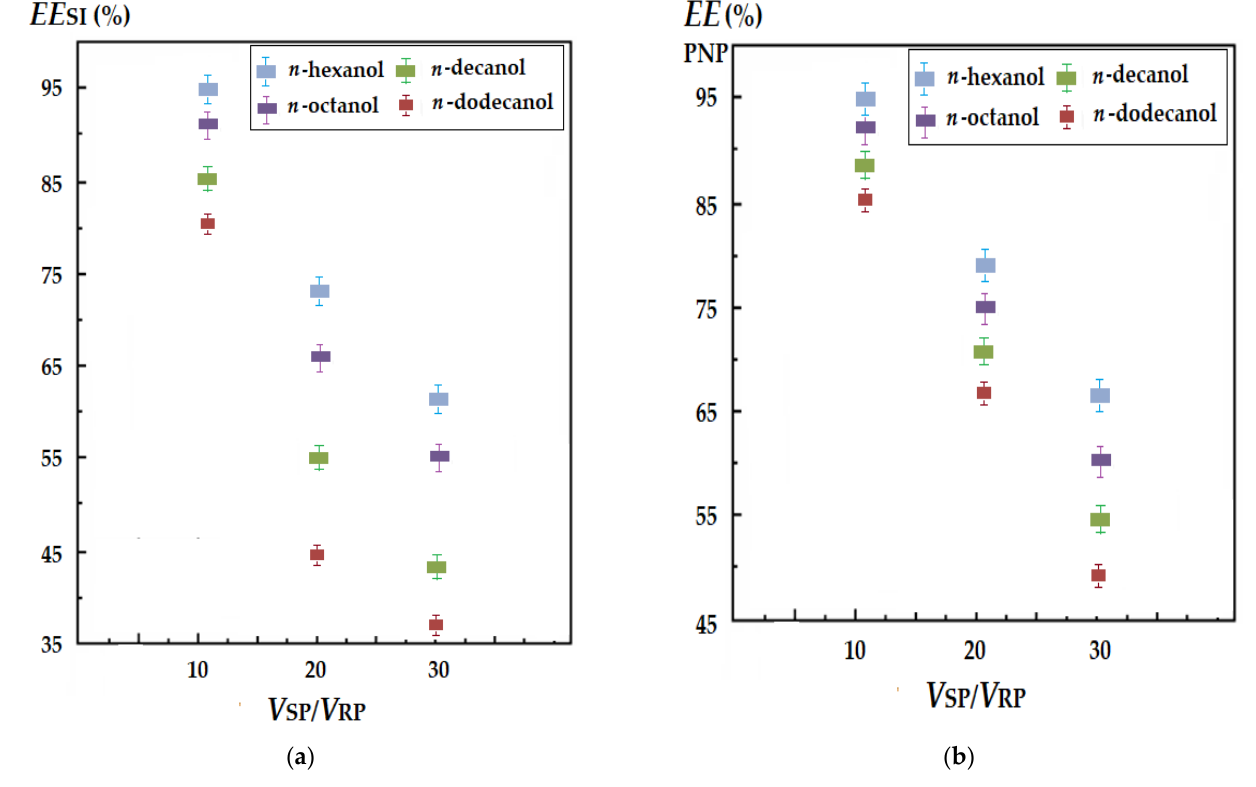
Figure 12. Efficiency of the separation of silver ions (SI) and p -nitrophenol (PNP) through a membrane of n -alkyl alcohols with 6, 8, 10 and 12 carbon atoms, having 10–undecenoic acid (UDAc) as a carrier, depending on the volume ratio of the source phase to the receiving phase: ( a ) for SI, pH = 1; ( b ) for PNP, pH = 13.